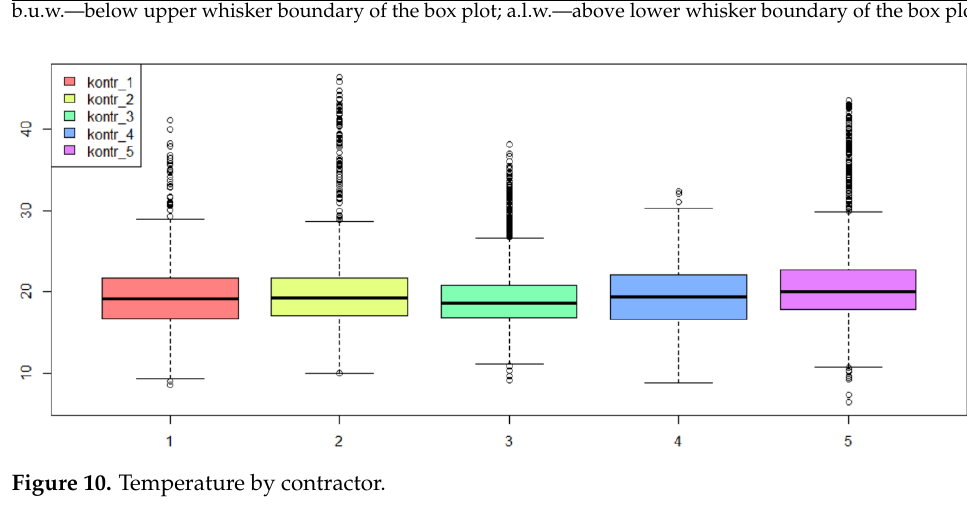
Figure 10. Temperature by contractor.